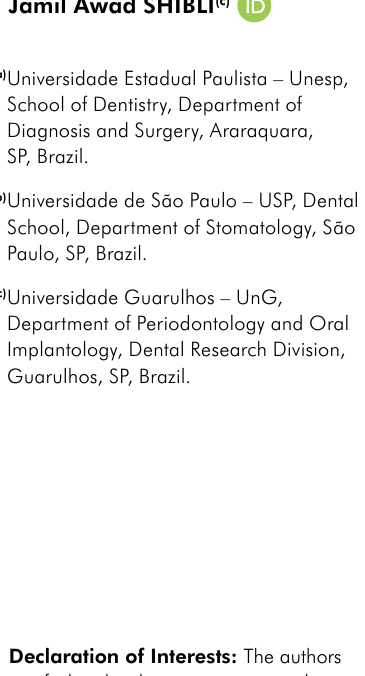
Figure. Number of papers published on PubMed using the search strategy “Dental Implant and